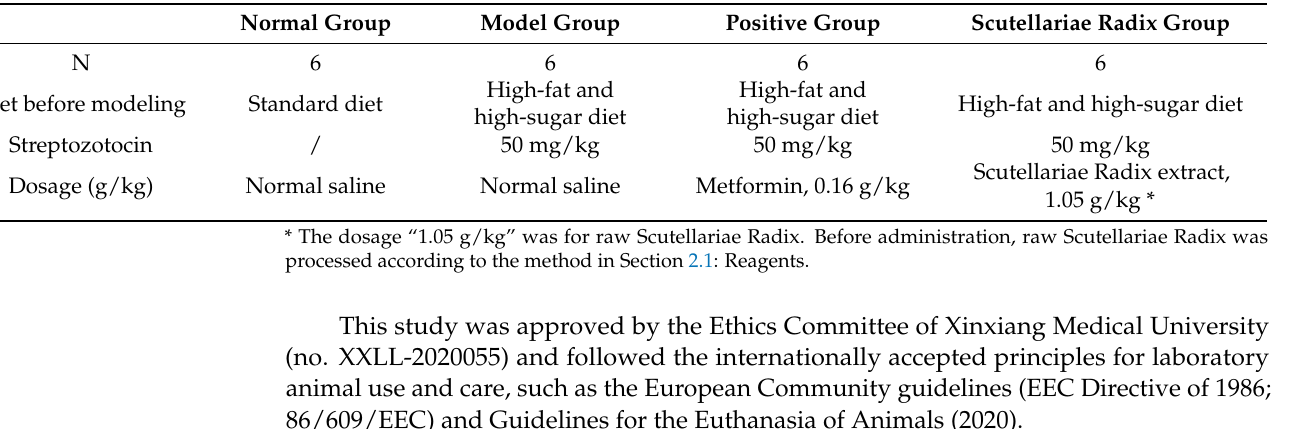
Table 1. The protocol of the animal